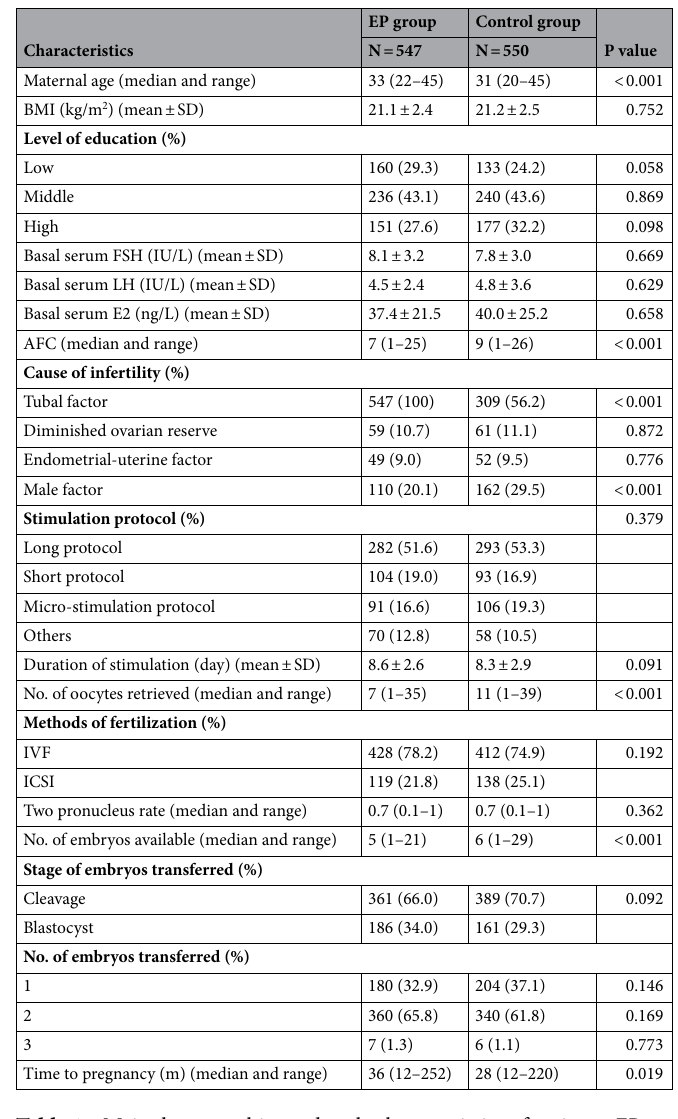
Table 1. Main demographics and cycle characteristics of patients. EP ectopic pregnancy, BMI body mass index, AFC antral follicle count, FSH follicle-stimulating hormone, LH luteinizing hormone, SD standard deviation, IVF in vitro fertilization, ICSI intracytoplasmic sperm